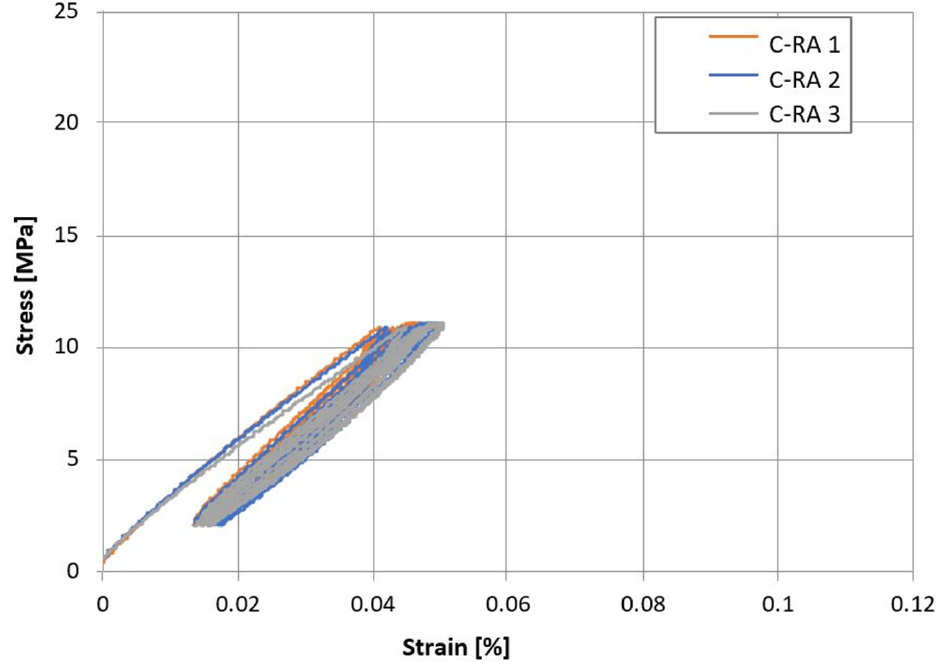
Figure 6. Stress–strain dependence for C-RA series concrete.